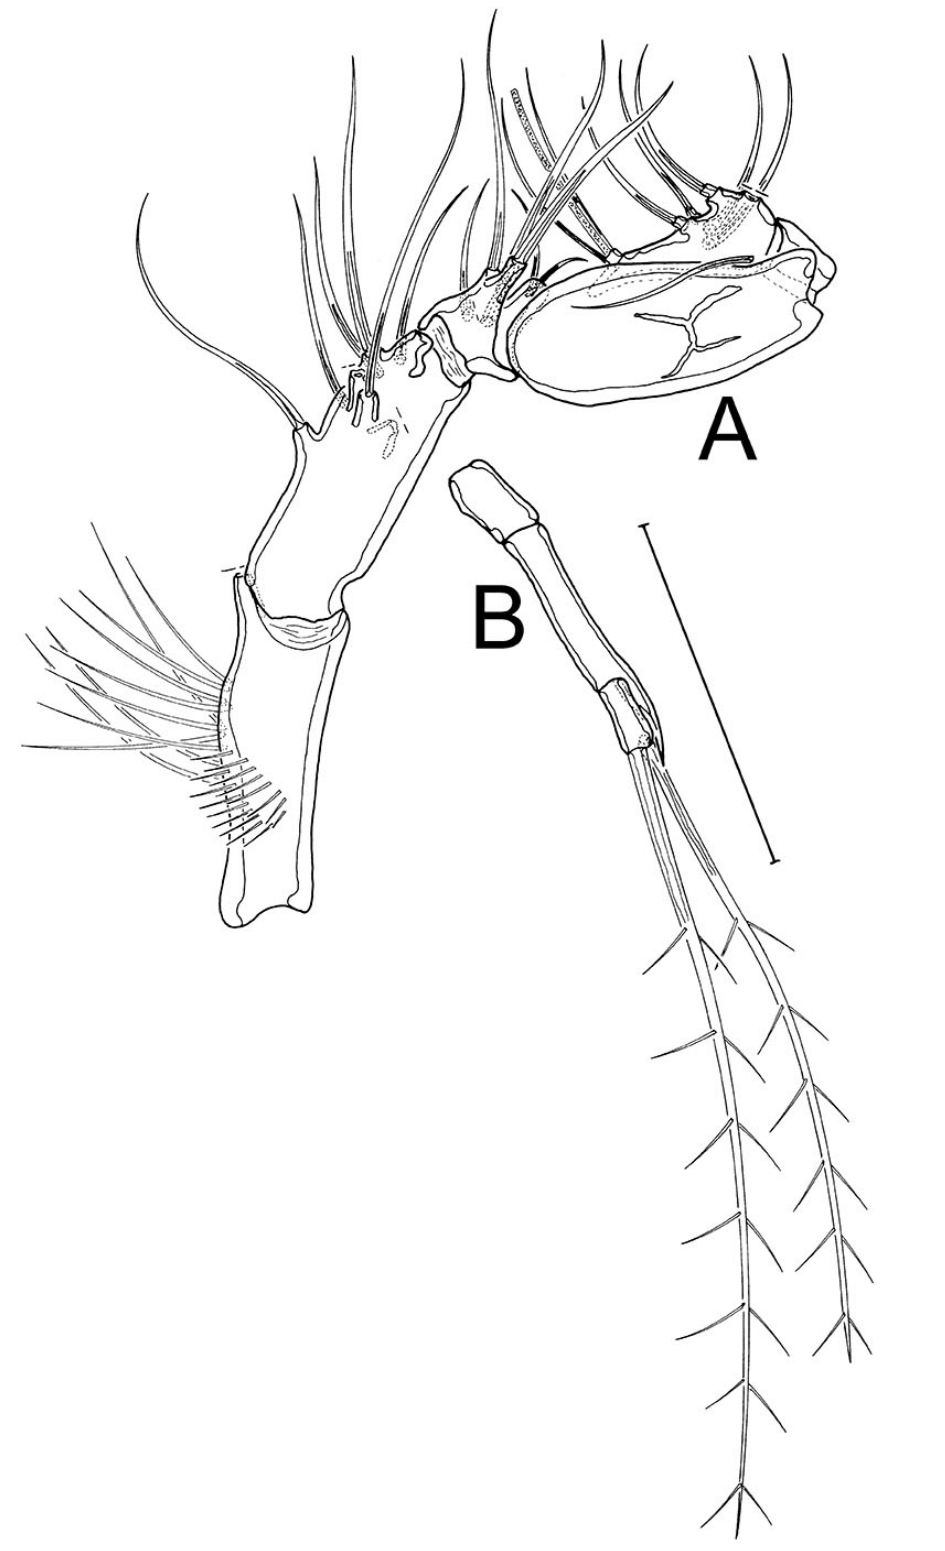
Fig. 14. Paratouphapleura aaroni gen. et sp. nov., male paratype 4 (SMF 37274). A . A1. B . P3 endopod. Scale bar: 50